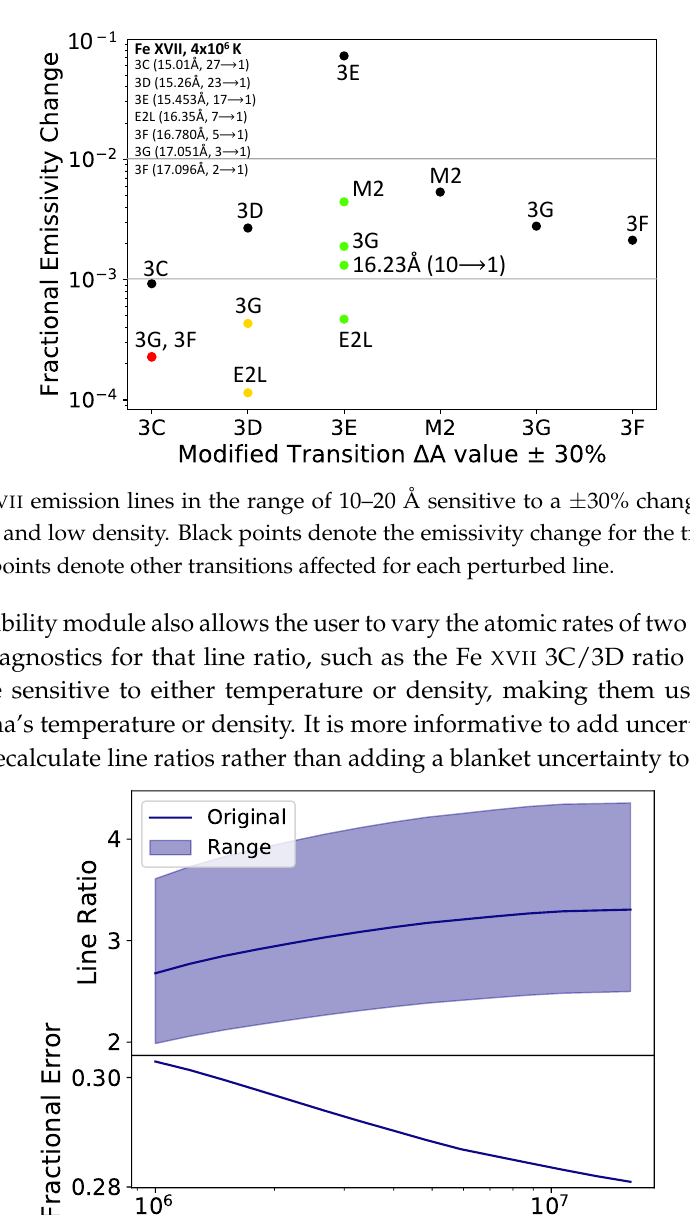
Figure 4. Fe XVII 3C/3D line ratio at low density as a function of temperature with a on the direct excitation rates of both the 3C and 3D lines. The final error on the line ratio is the entire temperature range